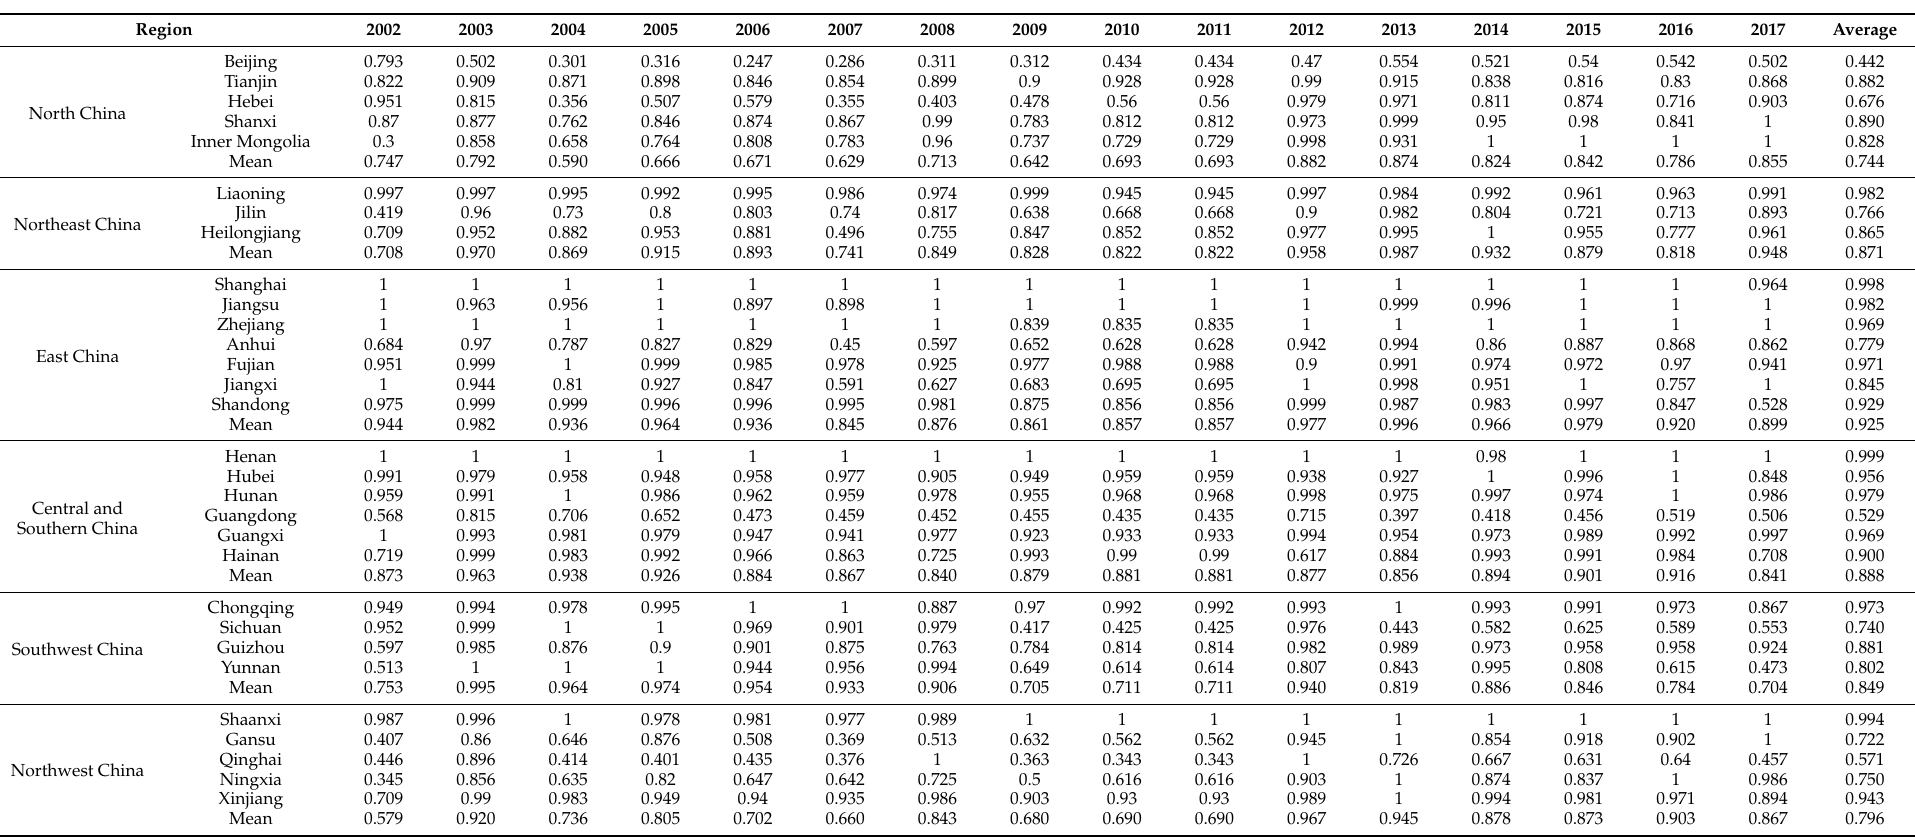
Table A2. The first stage scale efficiency results from BCC